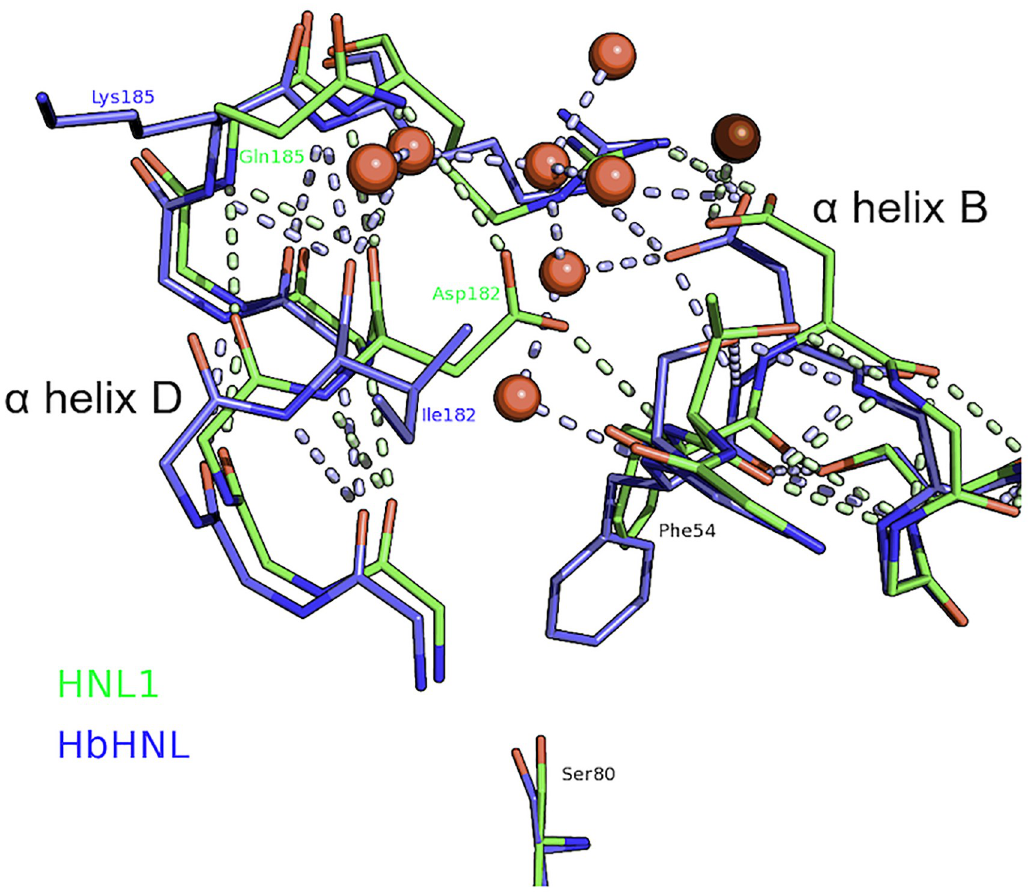
Fig 7. Hydrogen bonding network in HNL1 may contribute to higher thermostability. Aspartic acid 182 in HNL1 (green) hydrogen bonds directly to glutamine 185 and the backbone nitrogen of phenylalanine 54. This interaction bridges α helix B and the small α helix D. In contrast, Hb HNL (blue) hydrogen bonds indirectly to these helices via several water molecules (red spheres) that are absent from HNL1 (dark red sphere). Dashed lines indicate polar contacts. The bottom of the figure shows the catalytic serine for reference. The helices lie on the surface of the catalytic domain, but are not part of the substrate binding site. Fig 4 above shows the location of these helices within the whole structure.